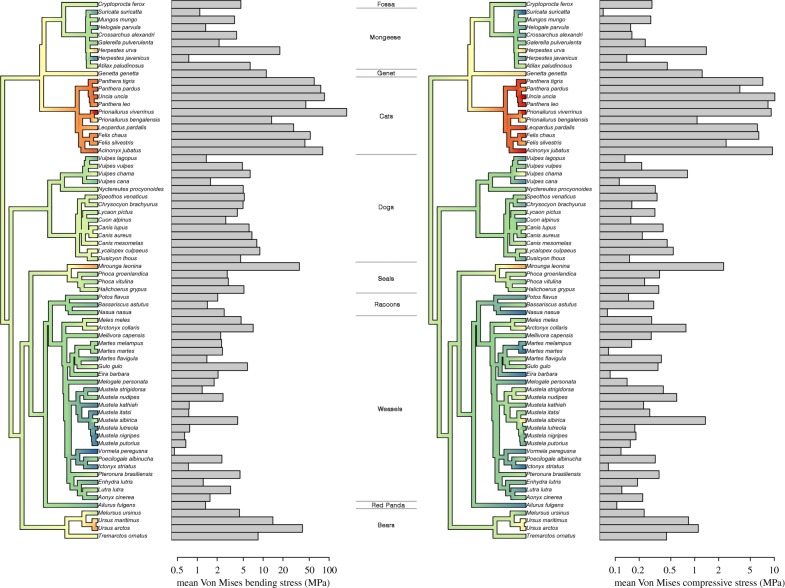
The phylogenetic distribution of mean Von Mises stress encountered during loading. Hot colours, high values of Von Mises stress; cool colours, low values of Von Mises stress. Consensus phylogeny sourced from the 10kTrees project (https://10ktrees.nunn-lab.org/Carnivora). (a) Mean Von Mises stress (MPa) under a bending load scenario. (b) Mean Von Mises stress (MPa) under a compressive loading scenario.